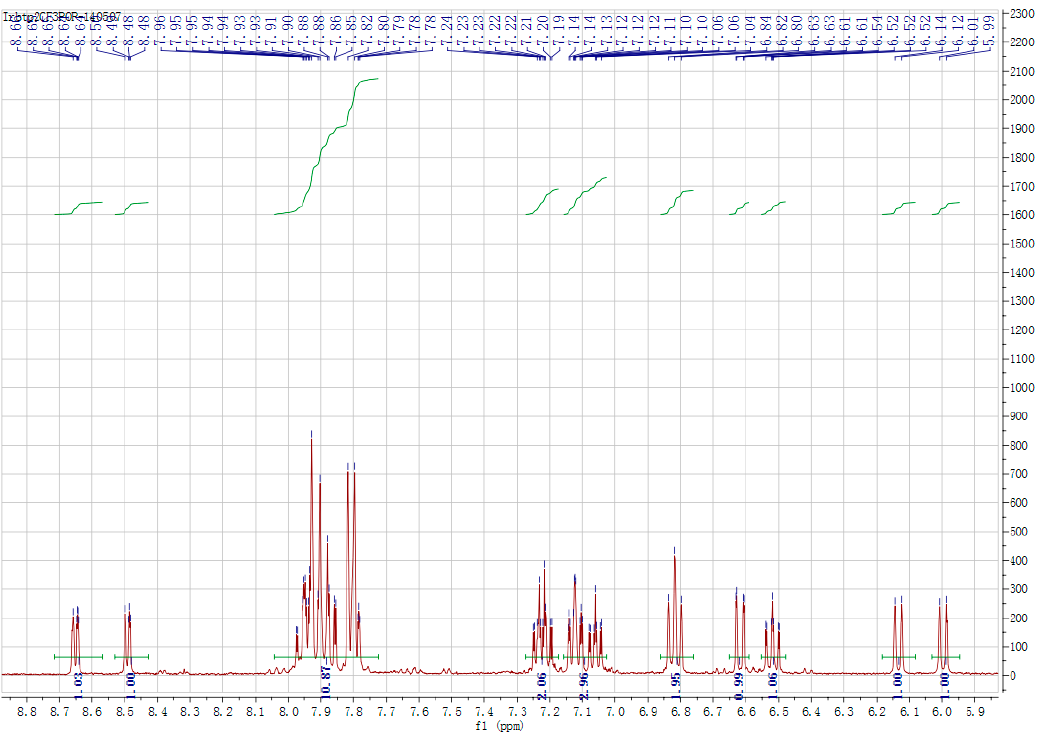
Figure 4. NMR spectra of coordination compound Ir2.